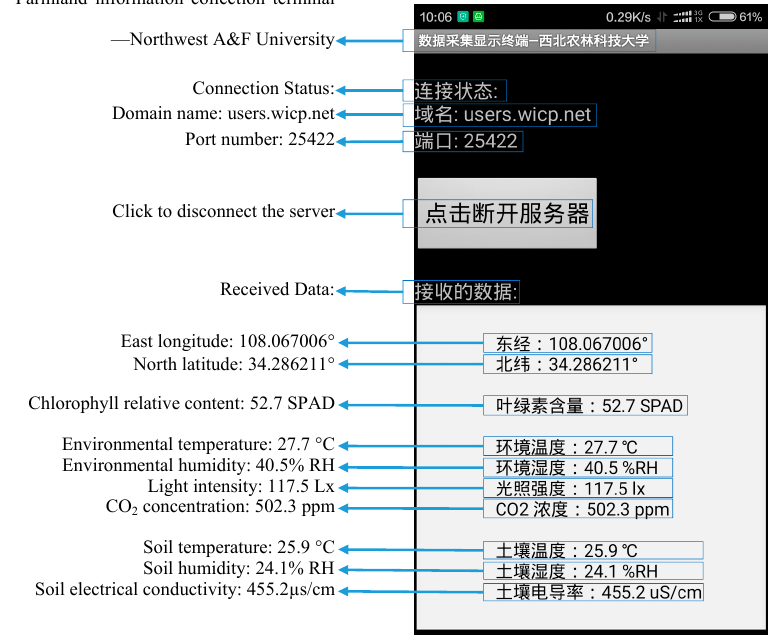
Figure 10. Interface of mobile phone APP in Chinese.